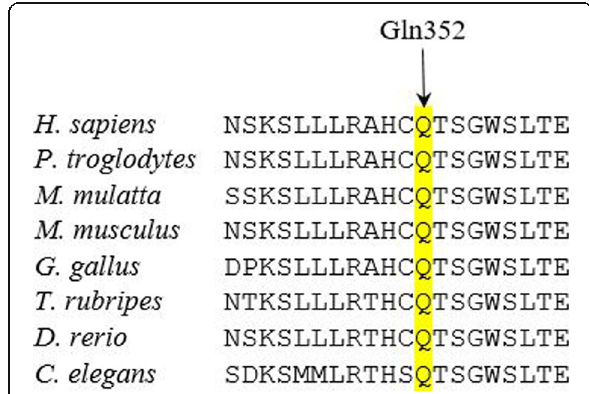
Fig. 2 Comparative amino acid alignment of MUT protein across different kingdoms. The highly conserved glutamine residue is highlighted